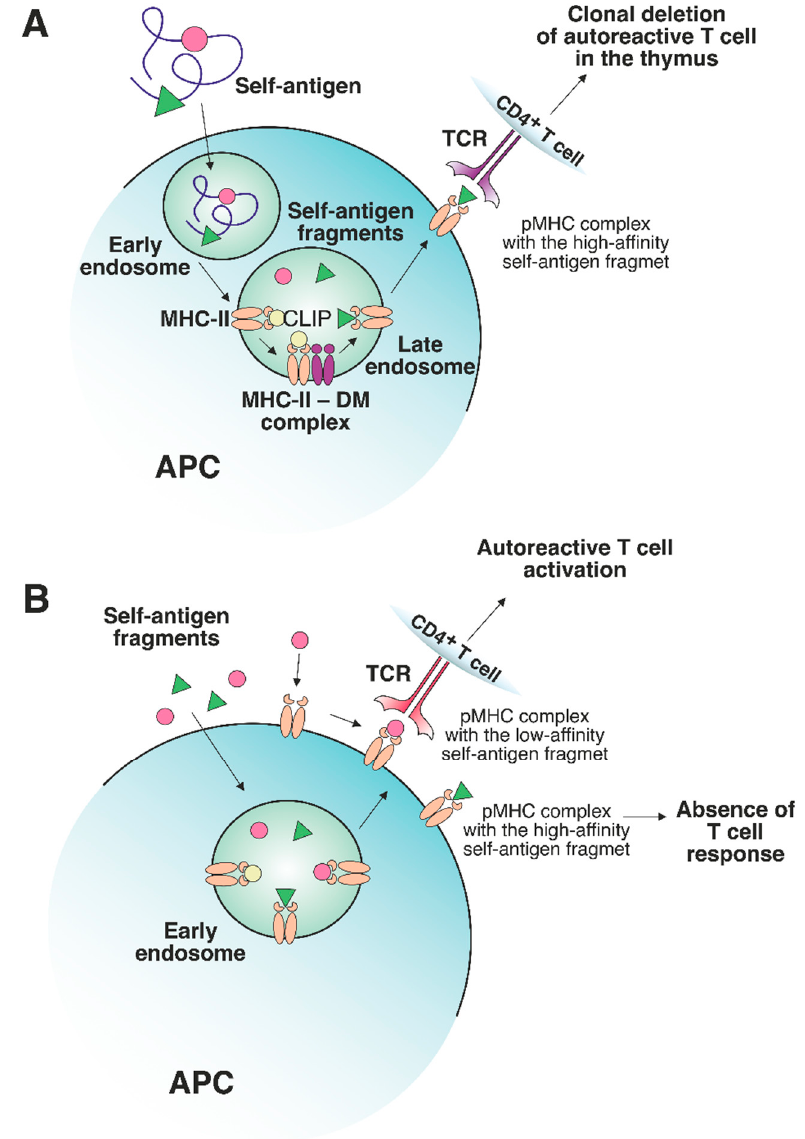
Figure 3. The role of a nonclassical DM molecule in the editing of the self-antigen repertoire pre- sented by MHC-II. ( A ) In a thymic APC, the self-antigen is processed through a classical pathway under exposure to cellular proteolytic enzymes. Next, CLIP is exchanged to the high-affinity frag- ment in late endosomes under DM control. The stable pMHC complex is then transferred to the APC surface, where the T cells specific to this pMHC undergo clonal deletion. ( B ) If an excessive amount of certain self-antigens, processed outside APCs, is present in peripheral tissues, then these self-antigen fragments can be loaded on MHC-II molecules in early endosomes or on the surface of APCs without the recruitment of DM. The absence of DM editing allows the emergence of either stable or unstable pMHC complexes. The pMHCs, containing high-affinity fragments, do not elicit a T cell response due to the deletion of autoreactive T cells in the thymus. Unstable complexes with low-affinity fragments can bind autoreactive T cells since such T cells are not susceptible to clonal